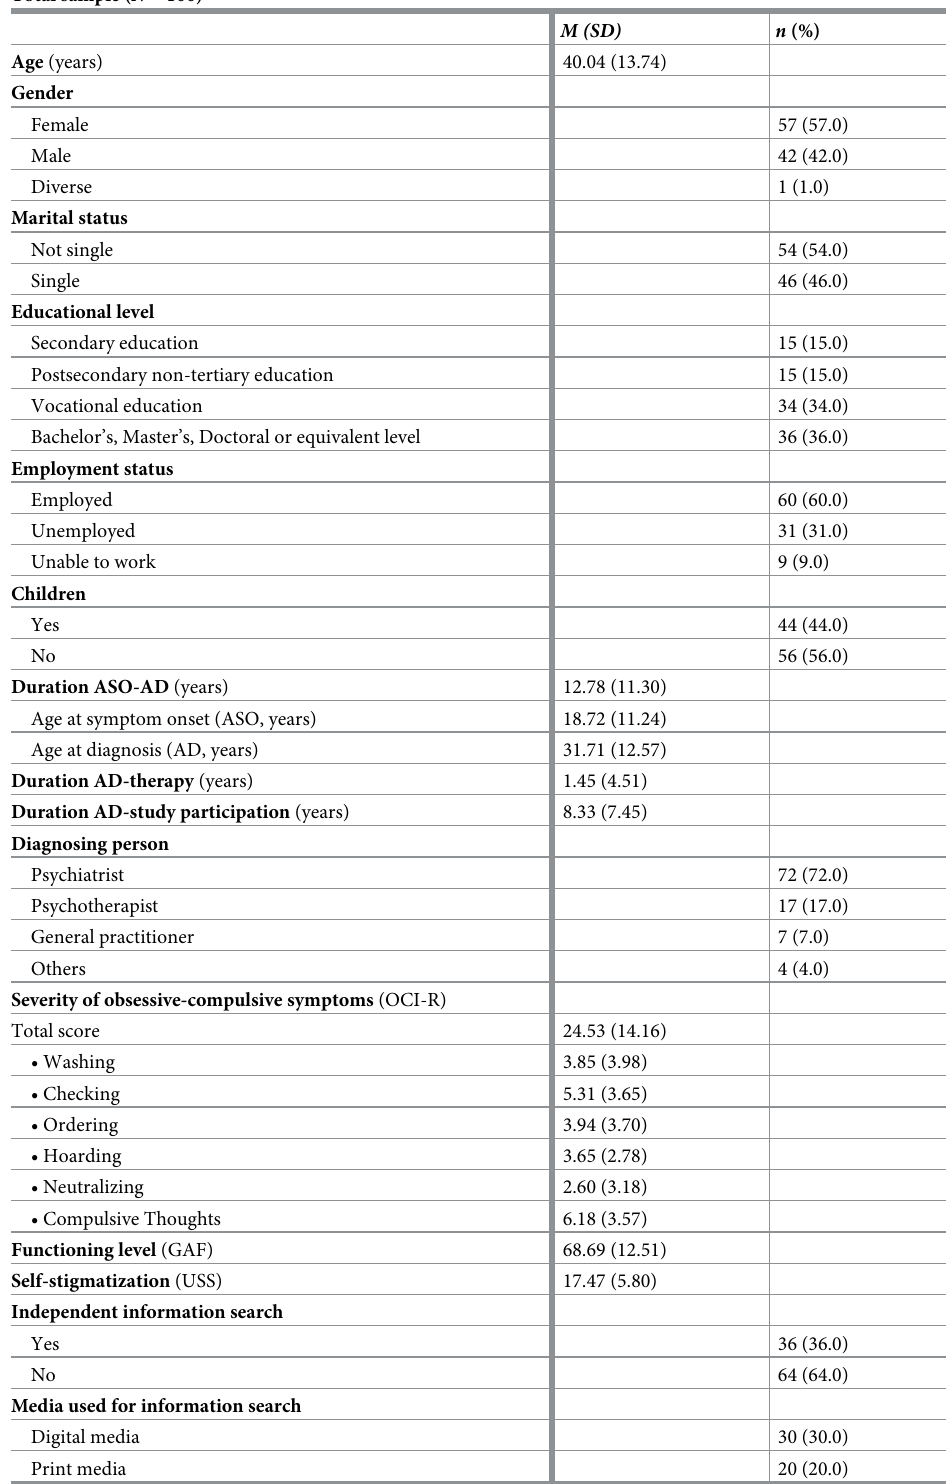
Table 1. Sociodemographic and clinical variables in the total